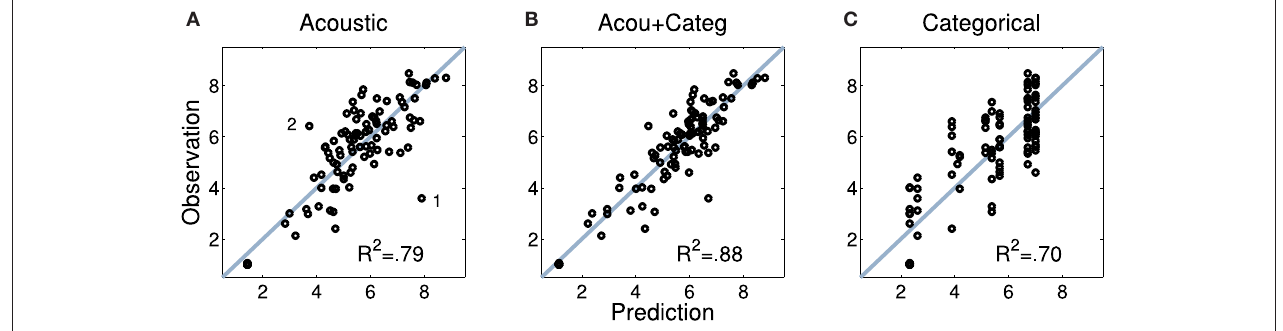
FIGURE 5 | Mean pairwise dissimilarity ratings for Set 1 (observations; y axis) and predictions based upon acoustic descriptors (A), audio and categorical predictors combined (B), and category membership of the instruments (C). Data points 1 and 2 in the left panel are discussed in the text.